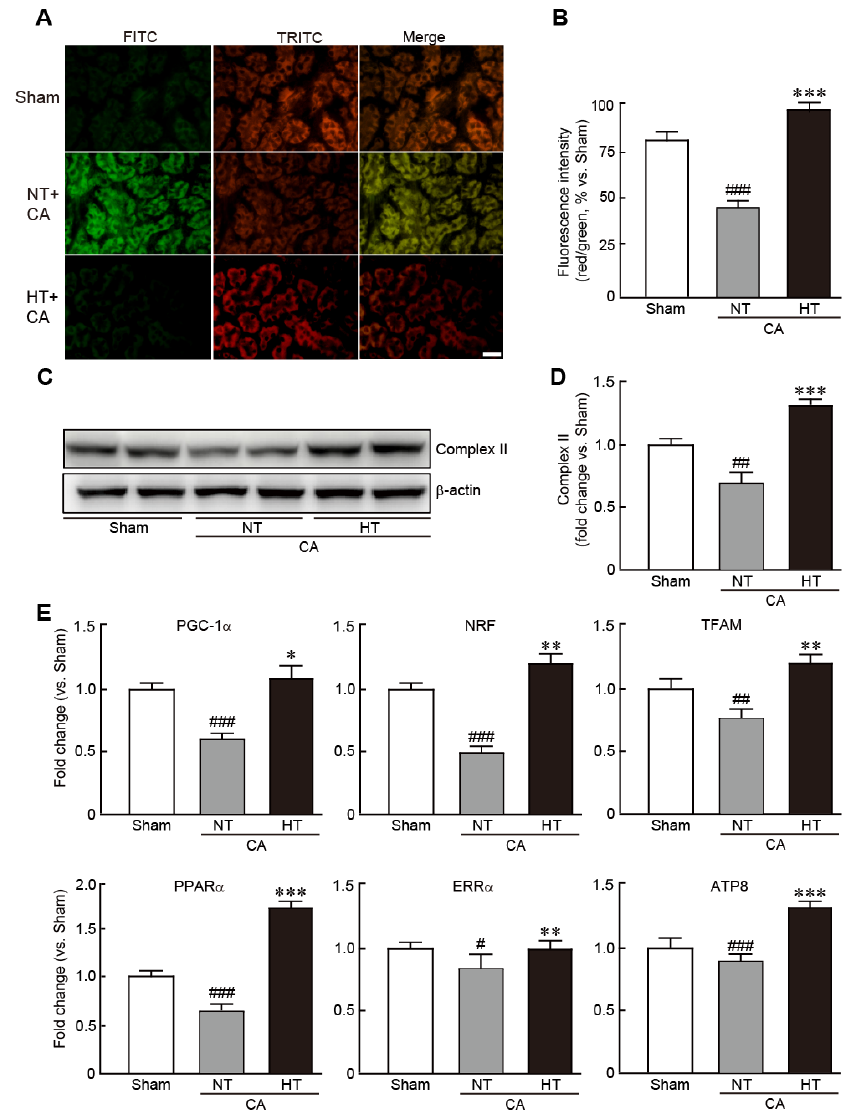
Figure 6. Olanzapine-induced TH preserves mitochondrial integrity affected by CA in renal tissues. Representative photographs ( A ) and intensities of red and green fluorescence ( B ), as observed by JC-1 staining of rat tissues after CA and ROSC with or without olanzapine-induced TH. ( C , D ) Western blot analysis for measuring the expression levels of mitochondrial complex II and β -actin proteins. ( E ) qRT-PCR analysis for measuring the mRNA expression levels of mitochondrial biogenesis- related genes ( n = 3 per group). Significance is represented as ## p < 0.01 and ### p < 0.001 vs. the